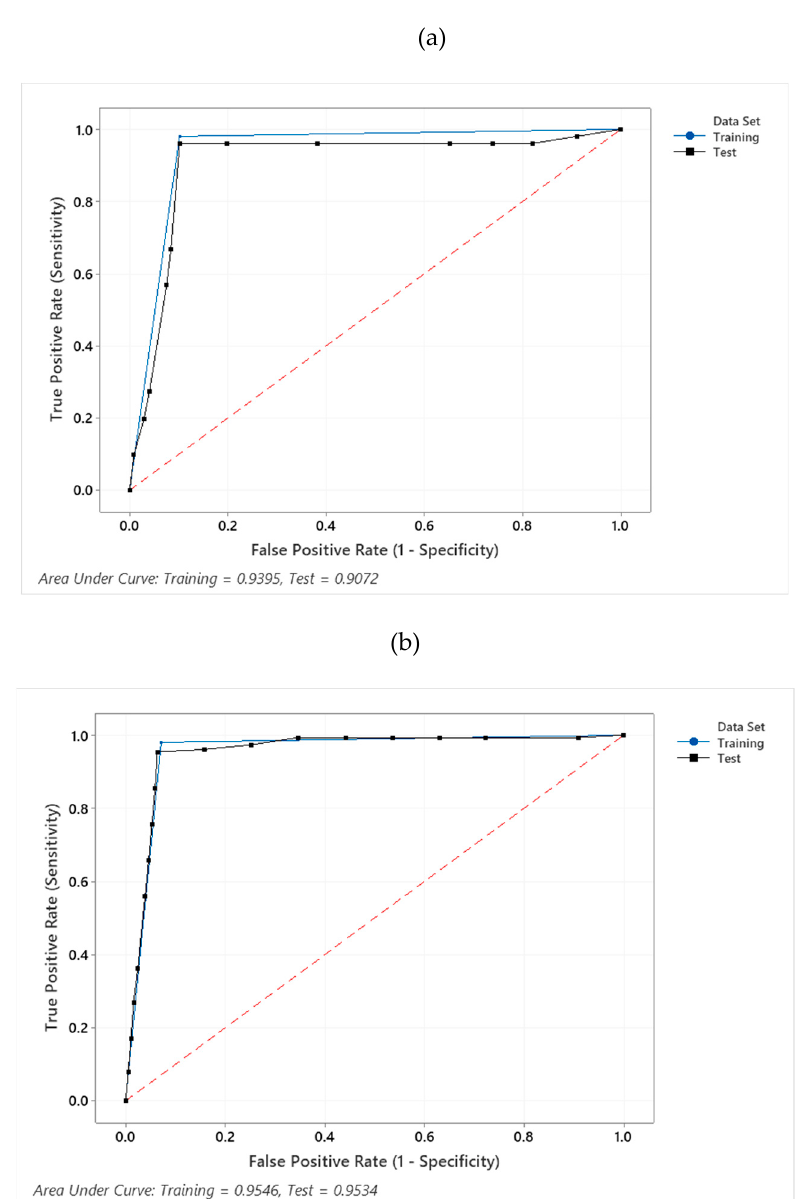
Figure 1. ( a ) Receiver operating characteristic (ROC) curve demonstrating the sensitivity and specificity of MI ≥ 24.5 for detecting play behaviour in 15 min sample intervals as calculated from a training dataset (blue line) and when applied to a test dataset (black line) using 10-fold cross validation. ( b ) Receiver operating characteristic (ROC) curve demonstrating the sensitivity and specificity of MI ≥ 2.5 for detecting play behaviour in 1 min sample intervals as calculated from a training dataset (blue line) and when applied to a test dataset (black line) using 10-fold cross validation.